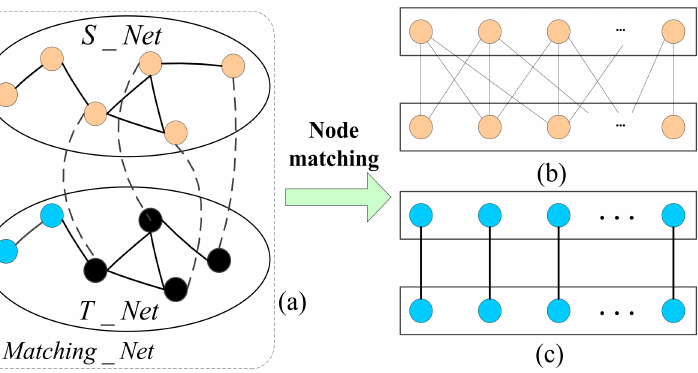
Figure 3. The schematic diagram of C3DPS node matching based on task-service network. ( a ) The matching_Net include S_Net and T_Net. ( b ) The mapping of C3DPSs node. ( c ) The mapping of C3DP order tasks